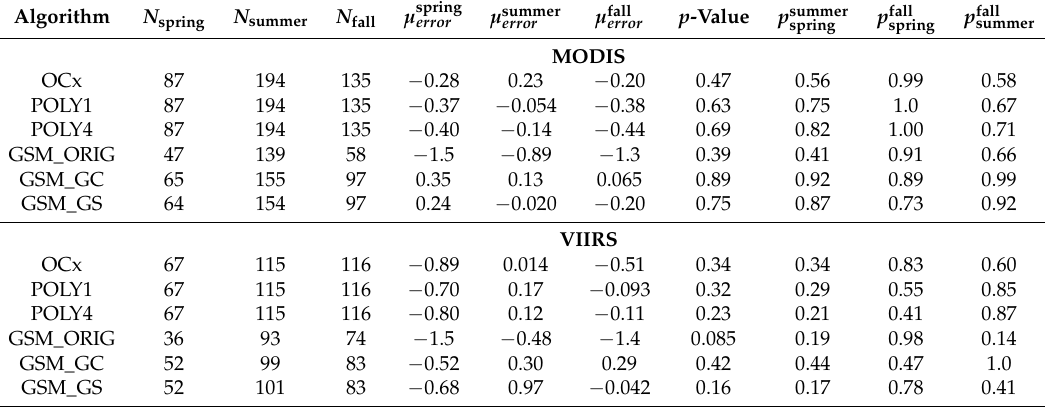
Table A4. Results of the ANOVA on µ error of seasonal subsets in the NEP, to check for statistically significant differences in means between seasons. The SeaWiFS subset has been excluded from this test, as all SeaWiFS matchups were collected during the summer, with the exception of a single matchup from fall and one from winter. Tukey Honest Significant Difference p -values between each pair of seasons are included to determine which seasons, if any, are statistically different from each